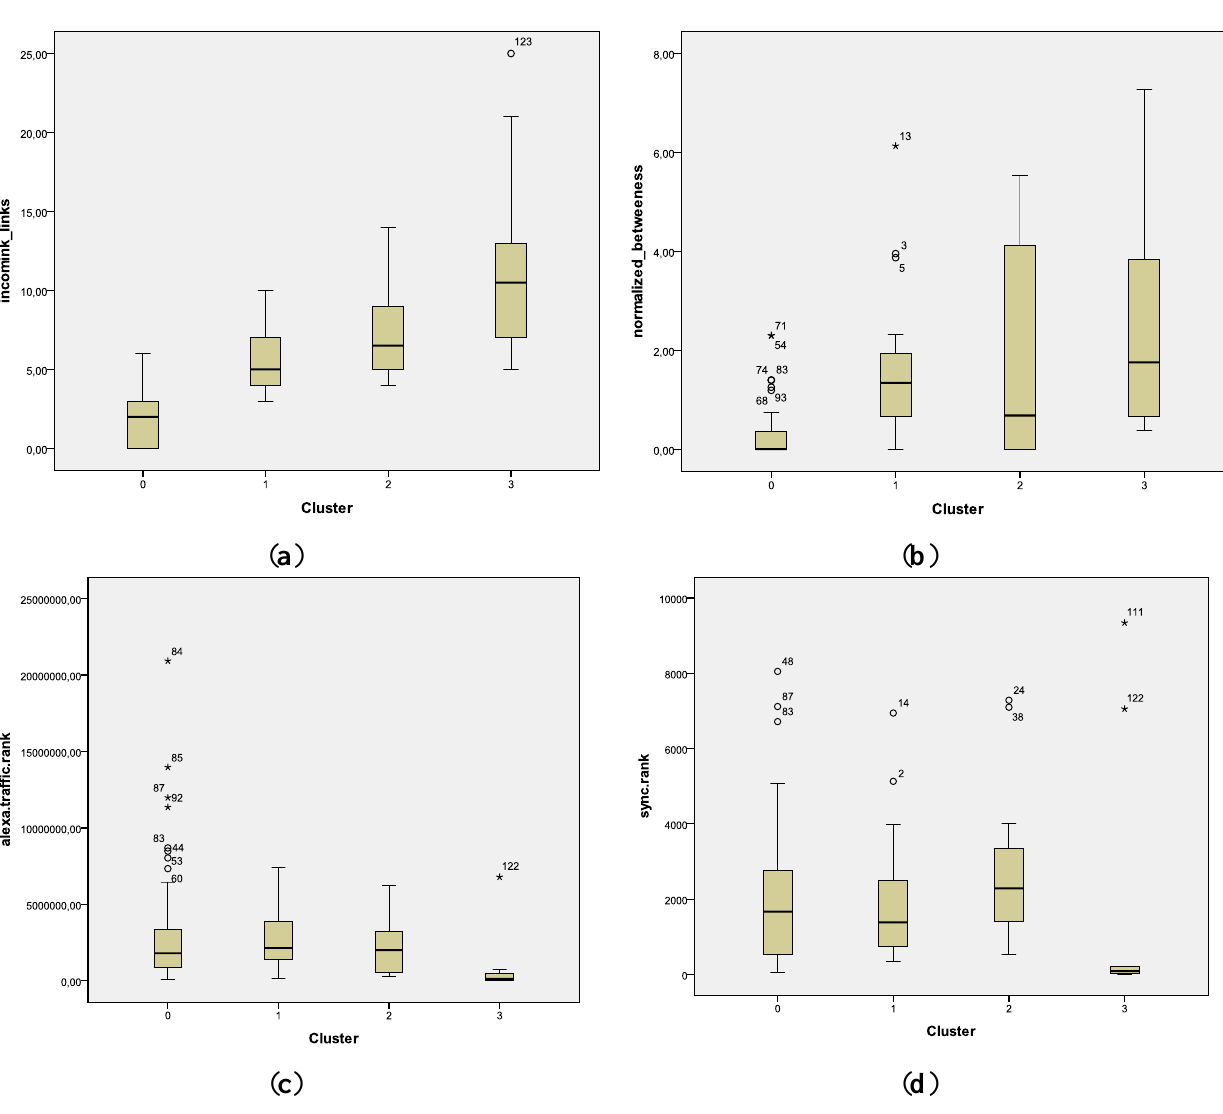
Figure 1. Boxplots of influence measures by clusters: ( a ) Incoming links by cluster; ( b ) normalized betweenness by cluster; ( c ) Alexa traffic rank by cluster; ( d ) Sync rank by cluster; ( e ) number of comments by cluster; ( f ) overall blogosphere authority score by